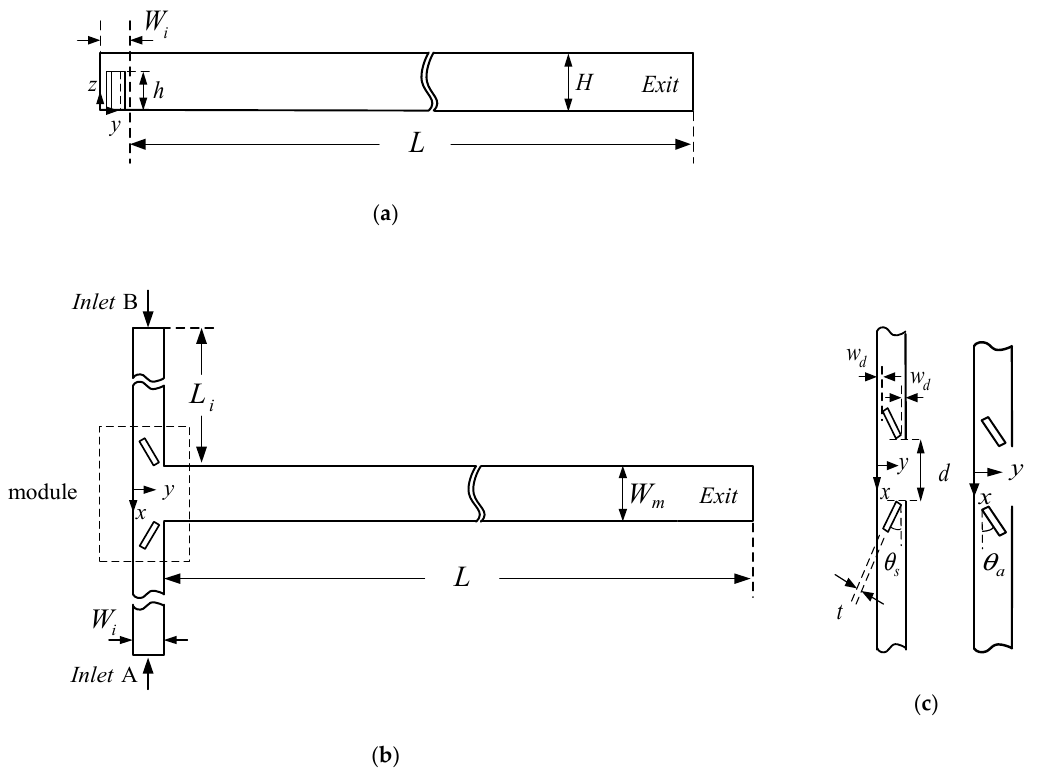
Figure 1. Schematic diagram and geometric parameters of T-shaped micromixers with vortex-inducing obstacles (VIOs) in the inlet channels: ( a ) side view, ( b ) top view, ( c ) inlet channel with symmetric VIOs ( Left ) and that with as antisymmetric VIOs ( Right ).